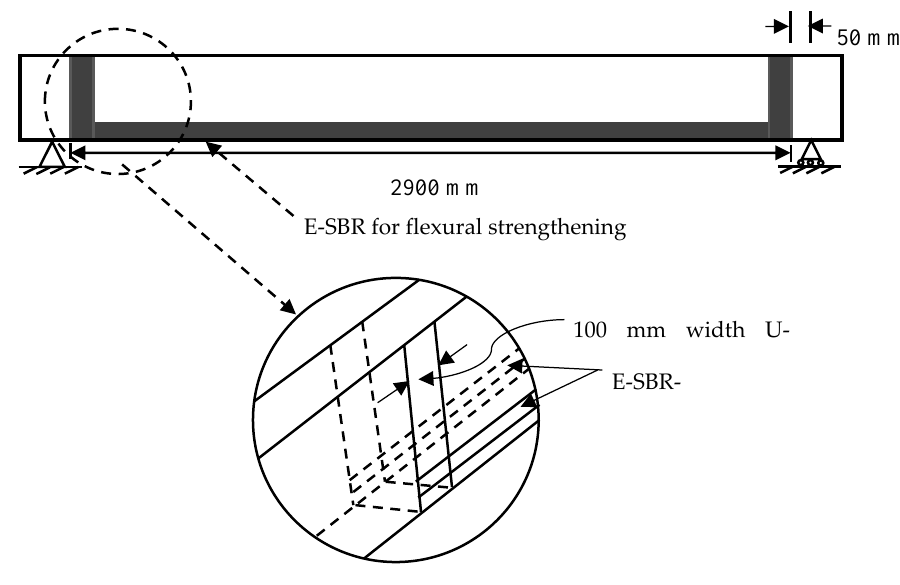
Figure 2. U-wrap end anchorage.